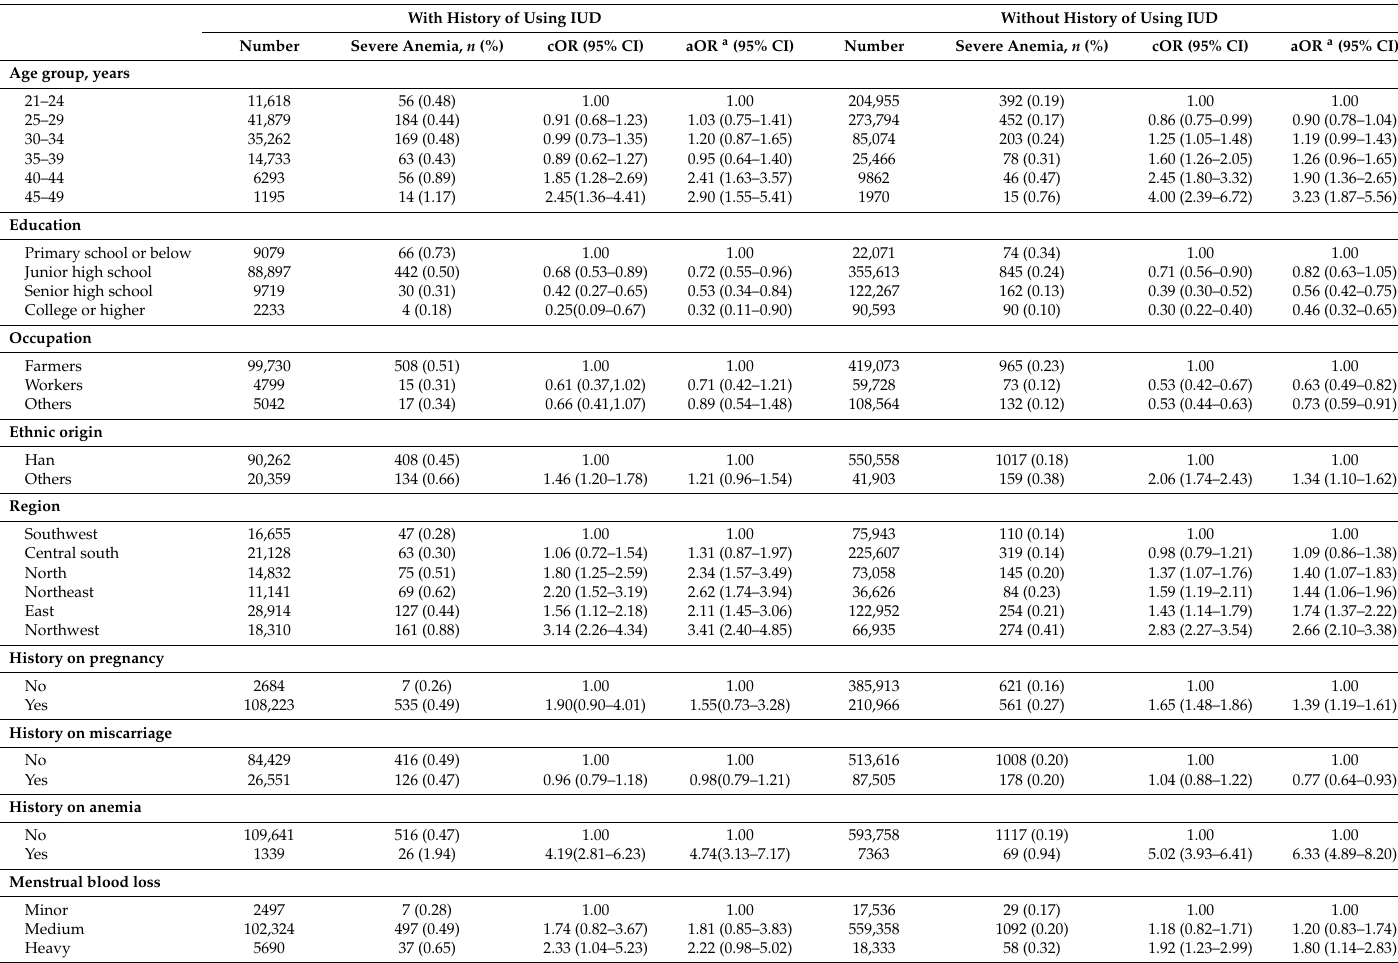
Table 3. Prevalence of severe anemia among non-pregnant women of reproductive age, stratified by history of using IUD in 2012, rural China. With History of Using